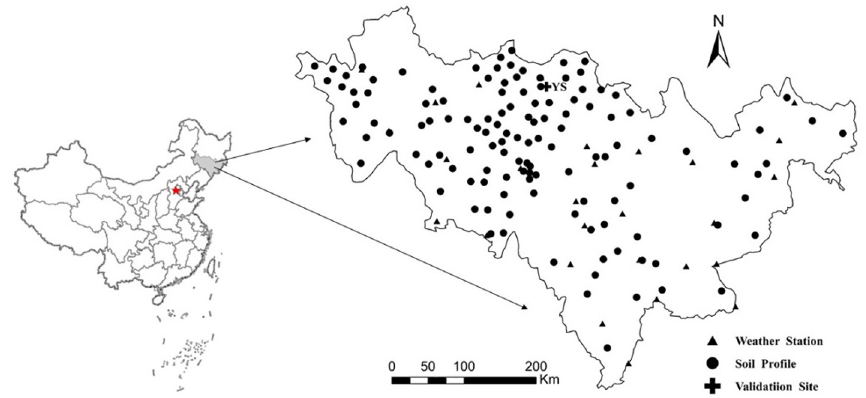
Fig 1. Geographical location of the study area indicating soil profile points and weather stations in Jilin Province, China.